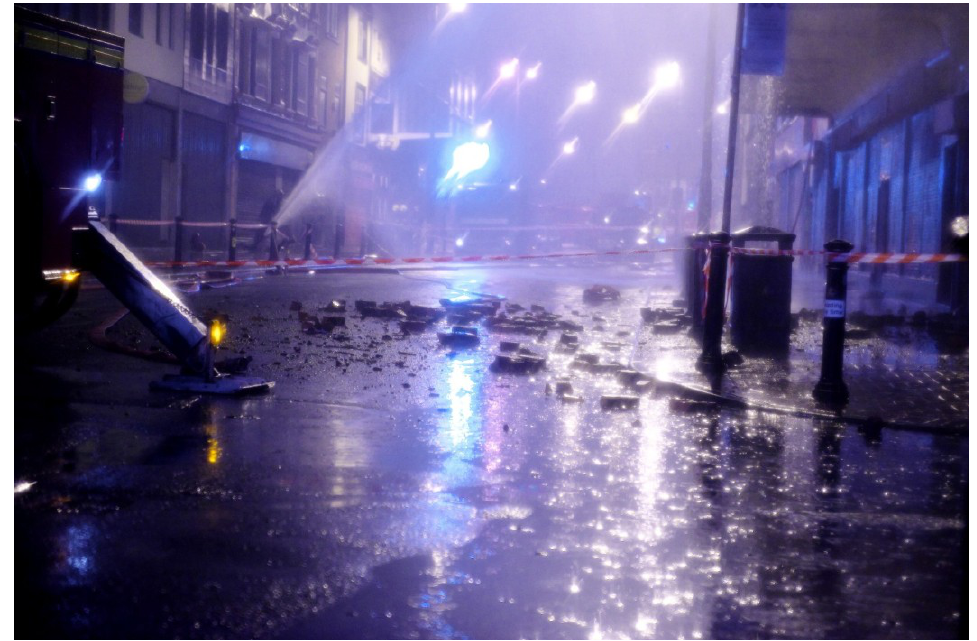
Figure 4. Example of an urban environment polluted by firewater runoff during the night (photograph provided by Ian